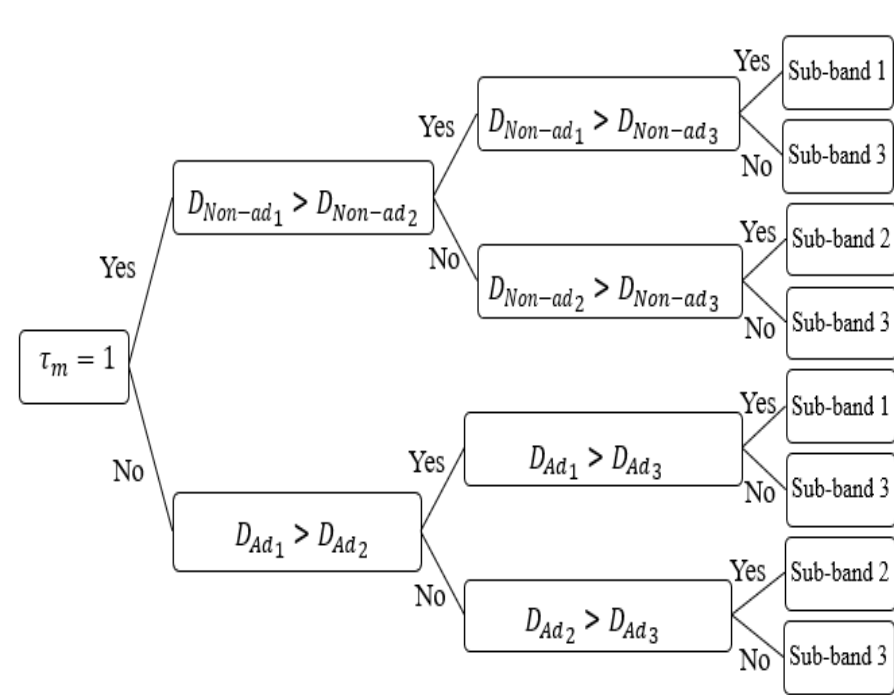
Figure 4. Classification tree (CT) example for three